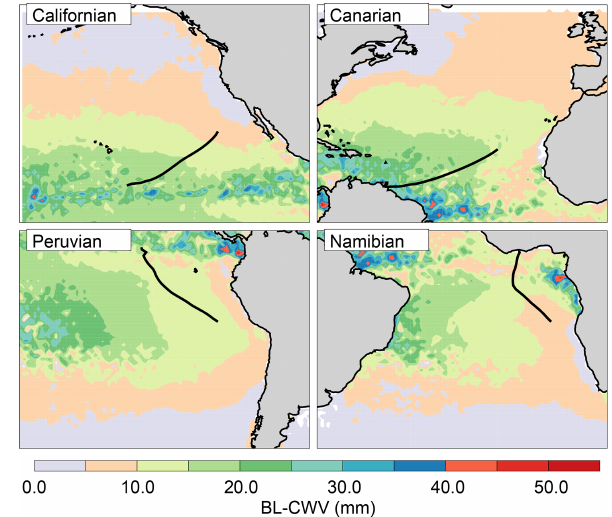
Figure 11. Transects along the climatological streamlines used in this study (taken from Sandu et al., 2010). The contours show the climatological composite for all the AMSR–MODIS BL-CWV data